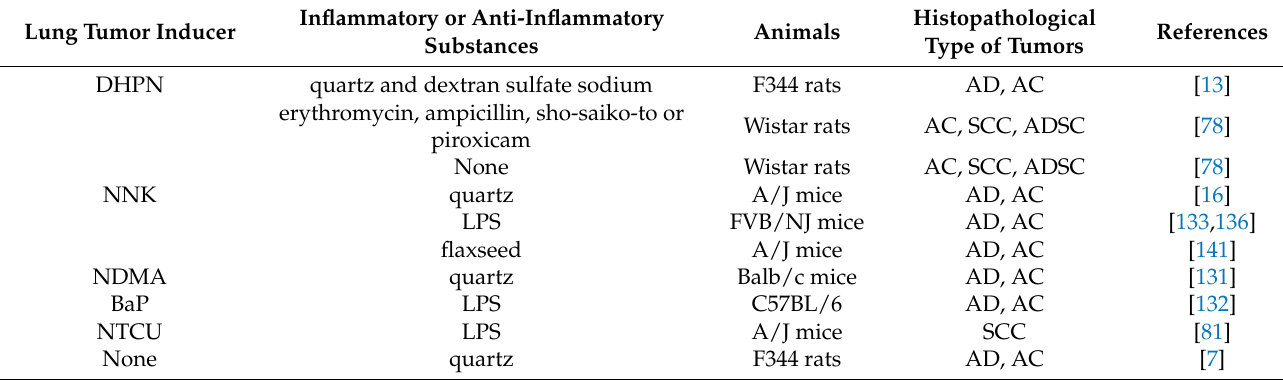
Table 3. Lung carcinogenesis models with